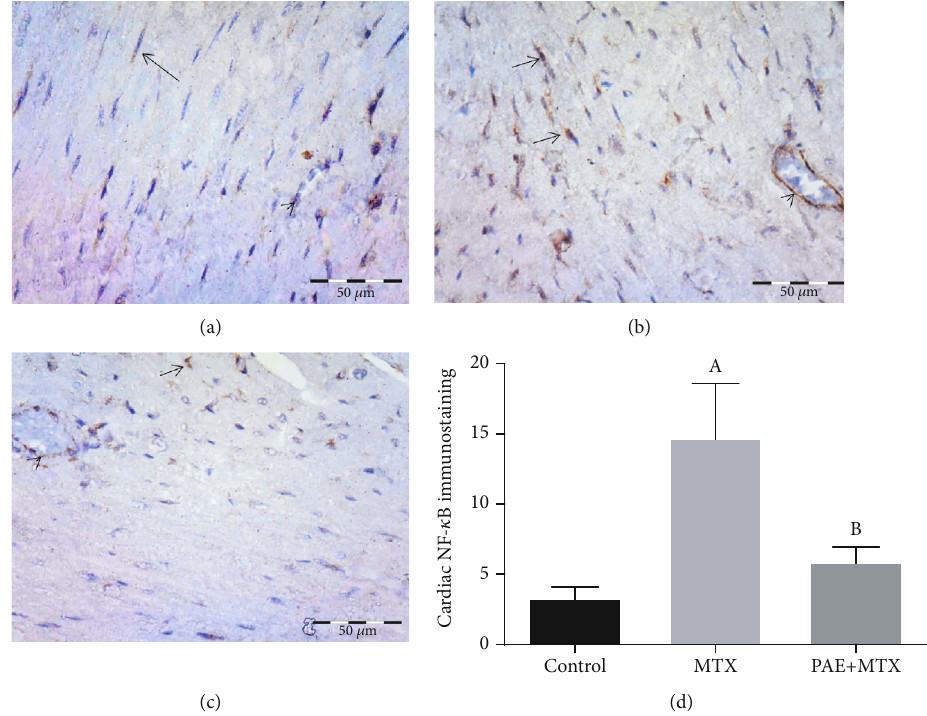
Figure 3: E ff ect of paeonol (PAE) on cardiac nuclear factor- (NF-) κ B/p65 immunostaining in methotrexate- (MTX-) induced cardiac toxicity in rats. (a) Control group showing positive expression in the cytoplasm of scattered cells of the endomysium (arrow). Notice negative expression in the endothelium (arrowhead). (b) MTX-treated group showing positive cytoplasmic and nuclear expression in many cells (arrows) and high expression in the endothelium (arrowhead). (c) PAE+MTX group showing positive expression in scattered cells (arrow) and low expression in the endothelium (arrowhead). (d) Semiquantitative analysis of the results. Values represent means ± SEM . “ A ” means signi fi cant di ff erence compared to the control group and “ B ” means signi fi cant di ff erence compared to the MTX-treated group, at p < 0 : 05 .